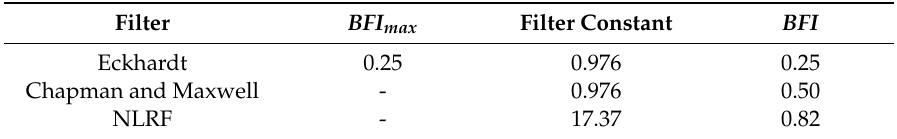
Table 1. Comparison of mean baseflow index ( BFI ) value for the period 1974 to 2013 using the Chapman and Maxwell, Eckhardt and nonlinear reservoir (NLRF) filters.